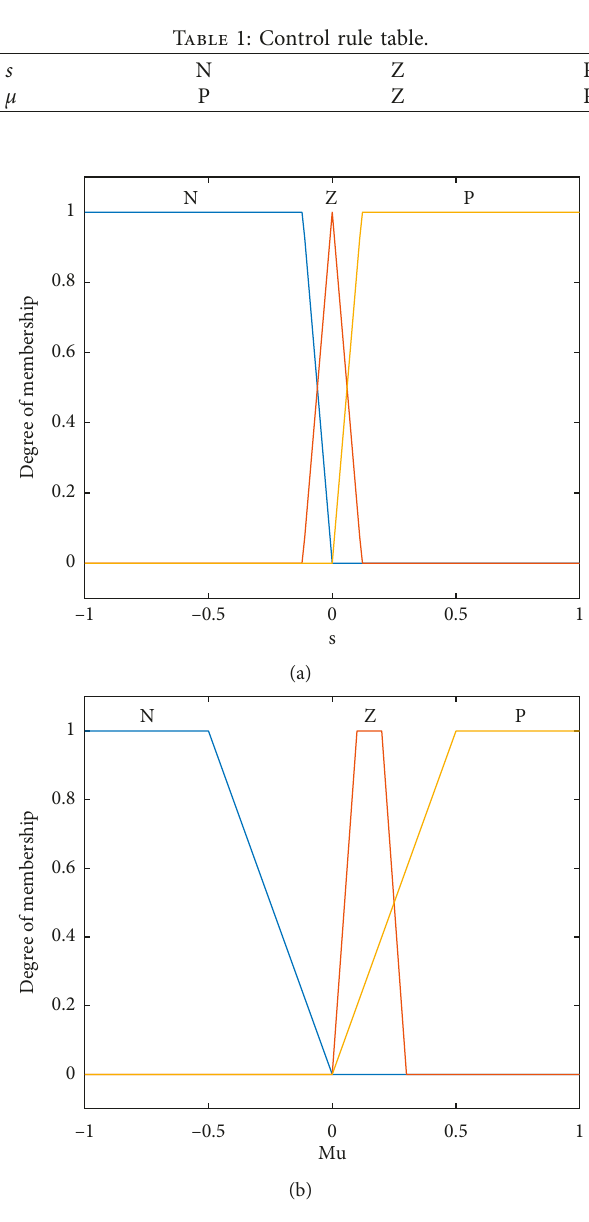
Figure 7: Membership function. (a) Membership function of the sliding mode function s. (b) Membership function of fuzzy factor μ